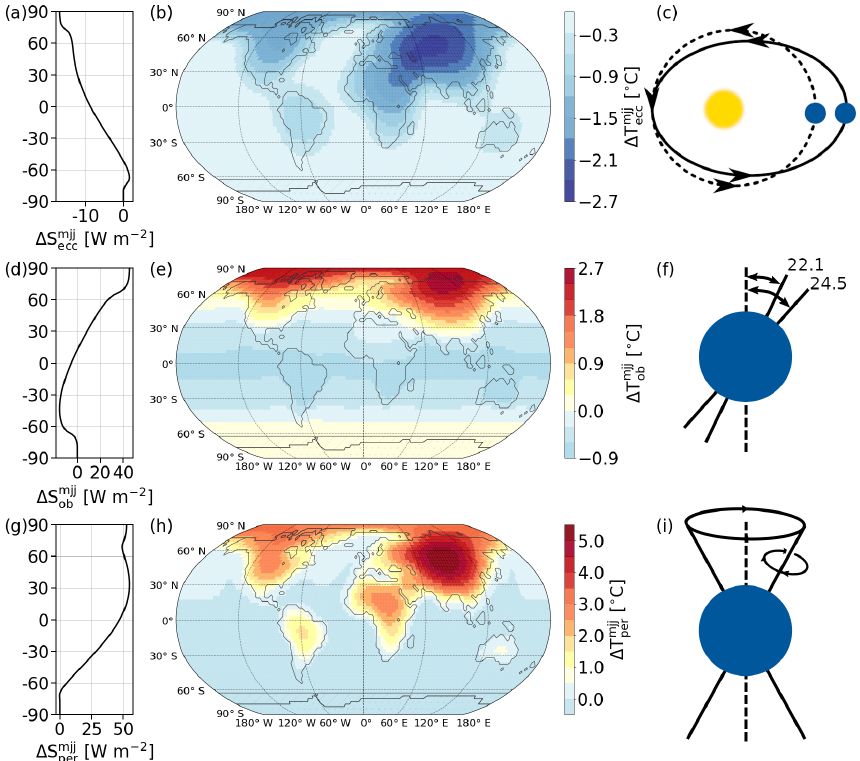
Figure 5. Difference that high and low orbital parameters as listed in Table 3 cause in solar insolation (left) and temperature field (middle) for the averages of the months May, June, and July (MJJ). A schematic illustration of the orbital parameters is added to the right. Equilibrium simulations with land, sea, and ice configuration as in Fig. 1 and constant CO 2 = 315ppm and S 0 = 1362Wm − 2 . (a–c) Eccentricity, (d– f) obliquity, and (g–i) precession of the position of perihelion. Precession shows the largest impact, followed by obliquity. High eccentricity results in overall lower insolation and temperatures; high precession overall resulted in increased insolation and temperatures. For eccentricity, decreased insolation in the north is found; for precession, on the other hand, insolation increases in the north. High obliquity results in increased insolation in the north and decreased insolation in the south. Precession acts strongest in lower and middle northern latitudes; obliquity and eccentricity, on the other hand, affect the high latitudes the